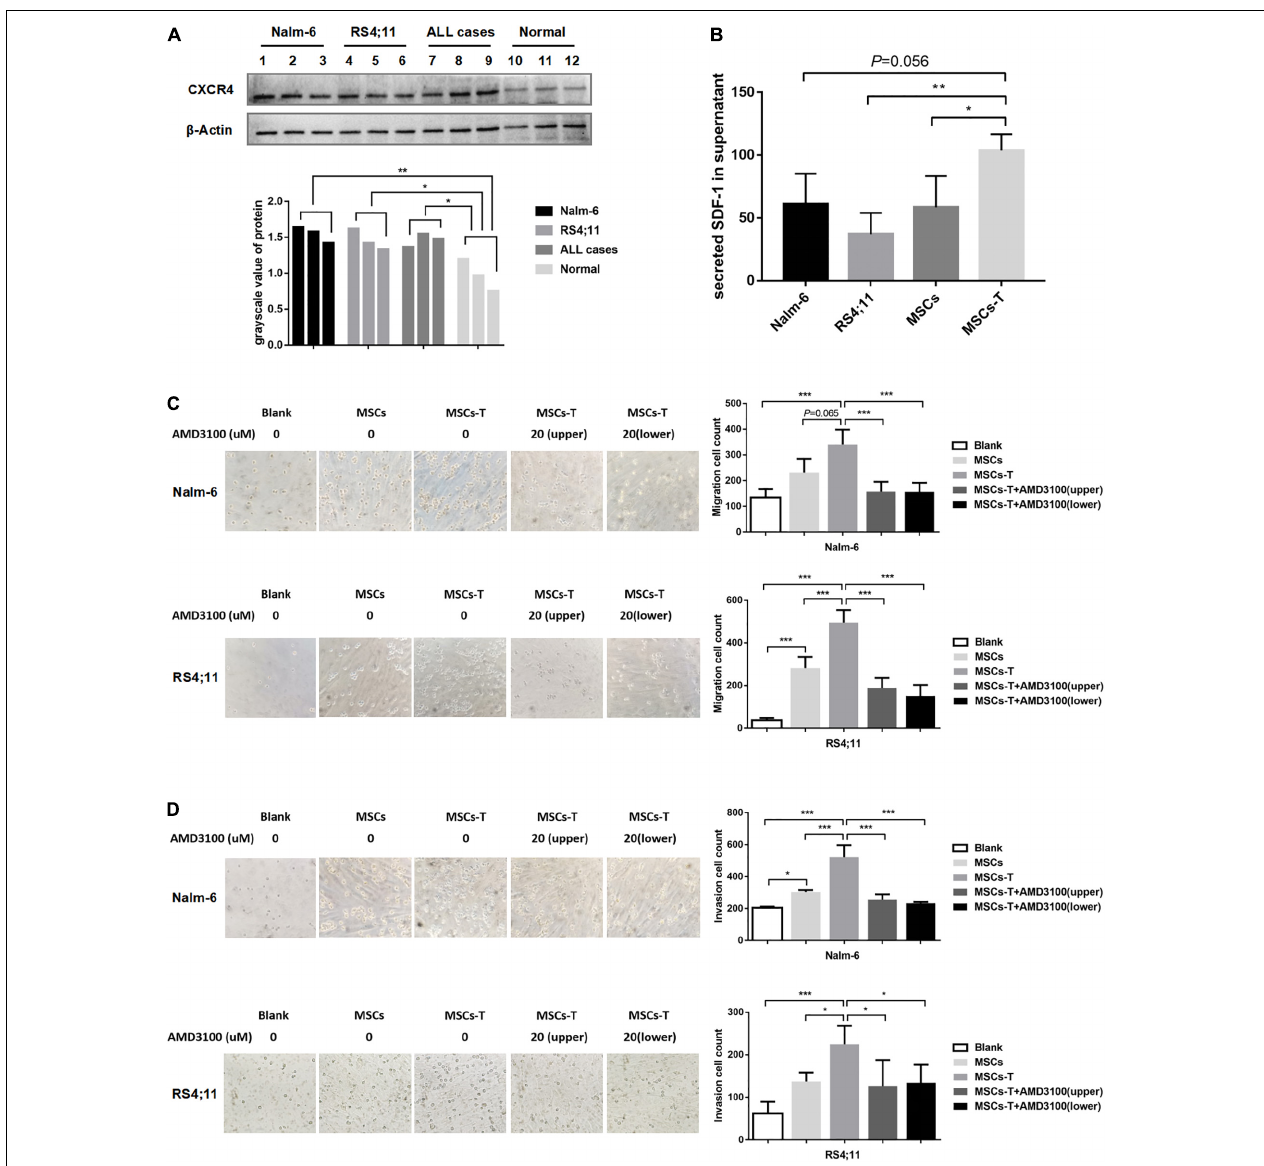
FIGURE 2 | Mesenchymal stem cells with CAF-like phenotype promoted the migration and invasion of ALL cells in vitro via SDF-1/CXCR4 signaling. (A) The expression of CXCR4 in Nalm-6 cell lines, RS4;11 cell lines, ALL cases ( n = 3) and bone marrow mononuclear cells of normal controls ( n = 3) by western blot. (B) ELISA showing the supernatant expression of SDF-1 (pg/ml) in the medium of Nalm-6 cell lines, RS4;11 cell lines, MSCs and TGF- β conditioned MSCs. (C,D) Transwell chamber test to detect the number of Nalm-6 and RS4;11 cells migration and invasion in blank, MSCs, TGF- β conditioned MSCs, TGF- β conditioned MSCs + AMD3100 (20 µ M, upper chambers) and TGF- β conditioned MSCs + AMD3100 (20 µ M, lower chambers) group after 24 h of cells incubation. Each value indicates the mean ± SD of three or more independent experiments ( Figures 2B–D ) or three independent samples ( Figure 2A ). In each independent repeated experiment, MSCs was isolated and cultured from a B-ALL patient, and stimulated with rhTGF- β to obtain the CAF-like phenotype, then the latter were compared with the untreated MSCs from the same patient to ensure that the experiment was comparable. * P < 0.05, ** P < 0.01, *** P <